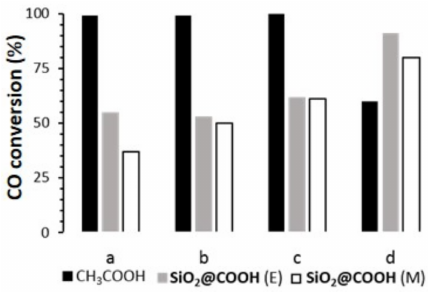
Figure 14. Comparison of CO conversion between different conditions for ( L )MnCl 2 (a), ( L )Mn(OTf) 2 (b), ( L )Mn( p -Ts) 2 (c), ( L )FeCl 2 (FeCl 4 ) (d).